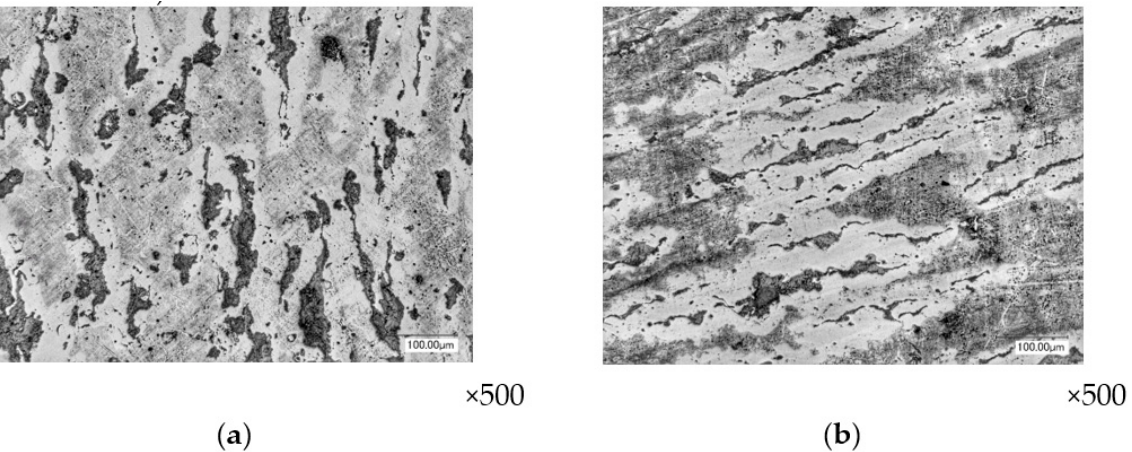
Figure 6. The shape of graphite inclusions in the side flange part of the forging (layer № 1): layered section ( a ) and end section ( b ).